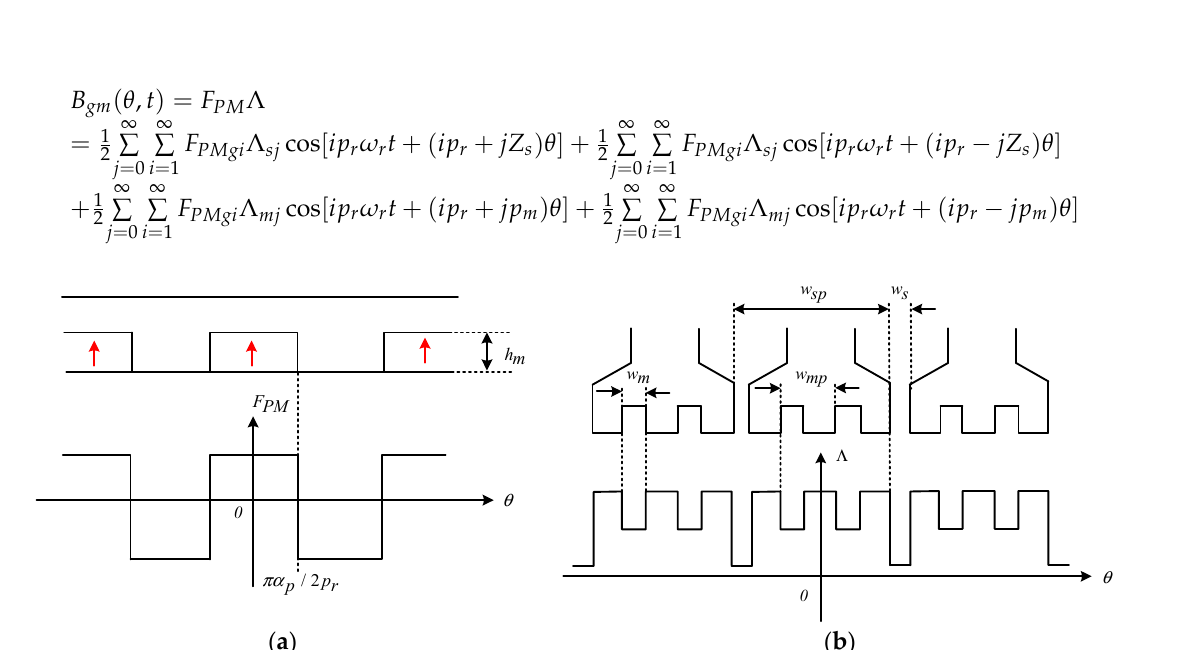
Figure 2. Air-gap MMF and permeance function distributions in the proposed machine. ( a ) The MMF distribution generated by the CPMs. ( b ) Λ accounts for the stator slotting.